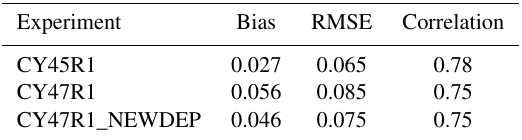
Table 11. Bias, RMSE and spatial correlation factor ( R ) of sim- ulated yearly sulfur wet deposition fluxes vs. CASTNET observa- tions (in gSm − 2 yr − 1